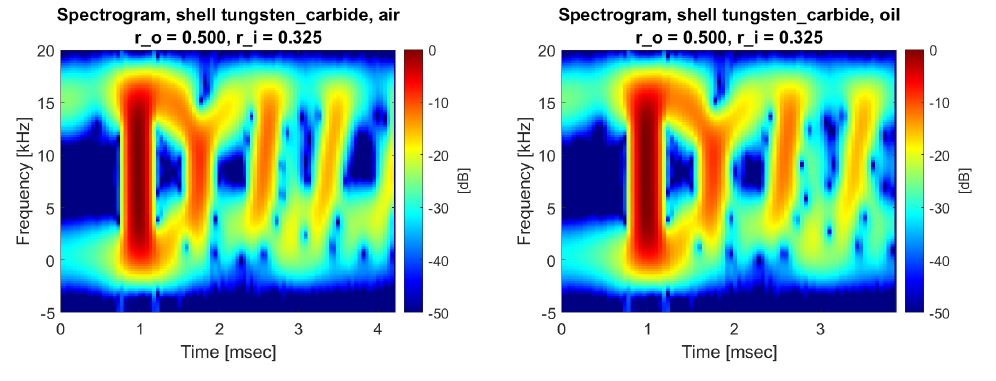
Figure 8. Similar spectrograms generated from tungsten carbide with a 20 dB SNR for thick shells filled with ( a ) air and ( b ) octane oil. The similar spectra results in the interior classification network had decreased accuracy. Units are in decibels and are in reference to the largest pixel